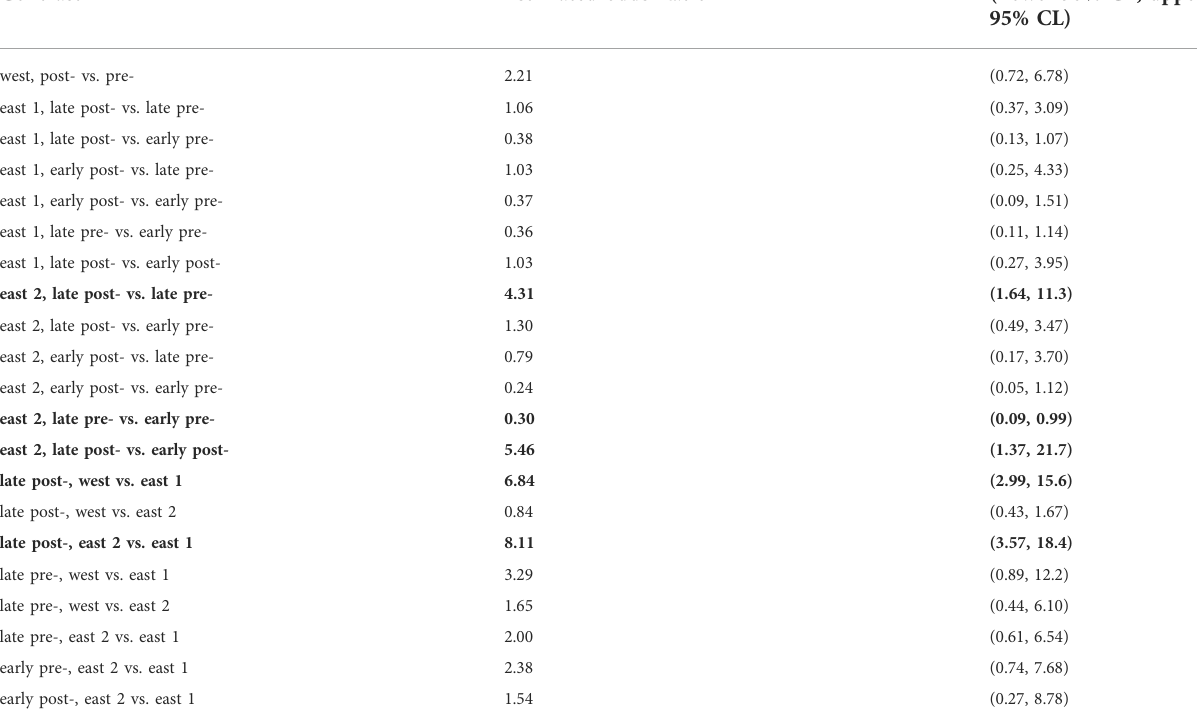
TABLE 2 Tests of contrasts in total submersed aquatic vegetation (SAV) estimated percent cover between treatment period: early pre-carp exclusion [1974]; late pre-carp exclusion [1997 and 2009 – 2010]; early post-carp exclusion [2014]; late post-carp exclusion [2016 – 2018], and marsh unit (west,east1,east2),DeltaMarsh,Manitoba.Contrastsarestatisticallysigni fi cant(bold)when95%con fi denceintervalsexclude1.00(CL=con fi dence limit). Contrast Estimated odds Ratio